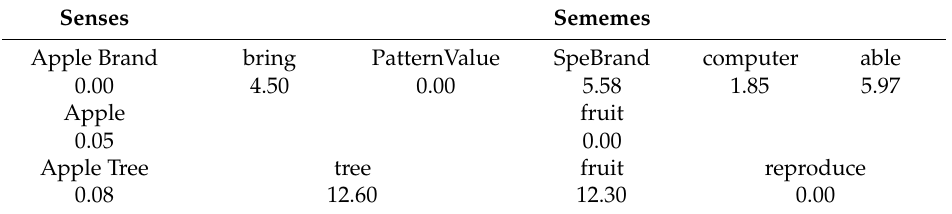
Table 7. “There are many kinds of high-quality apple ( Apple Tree) seedlings in southeast Asia.” Senses Sememes Apple Brand bring PatternValue 0.00 4.50 0.00 fruit 0.00 Apple Tree